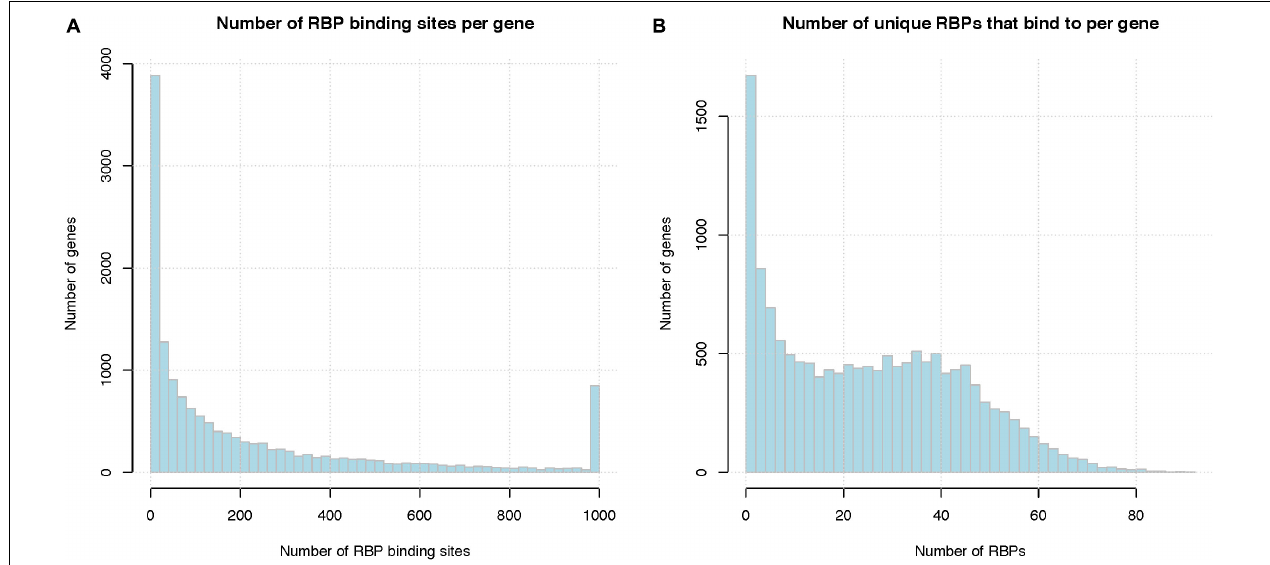
FIGURE 2 | Summary of RBP binding sites. (A) Number of RBP binding sites per gene, binding sites from different RBPs are pooled together. X -axis represents the number of RBP binding sites per gene and the last column represents the number of genes with total binding sites greater than 1000, Y -axis indicates the number of genes that have that number of RBP binding sites. (B) Number of unique RBPs that bind to a human gene. X -axis indicate the number of unique RBPs bound to one mRNA, Y -axis indicates the number of genes.